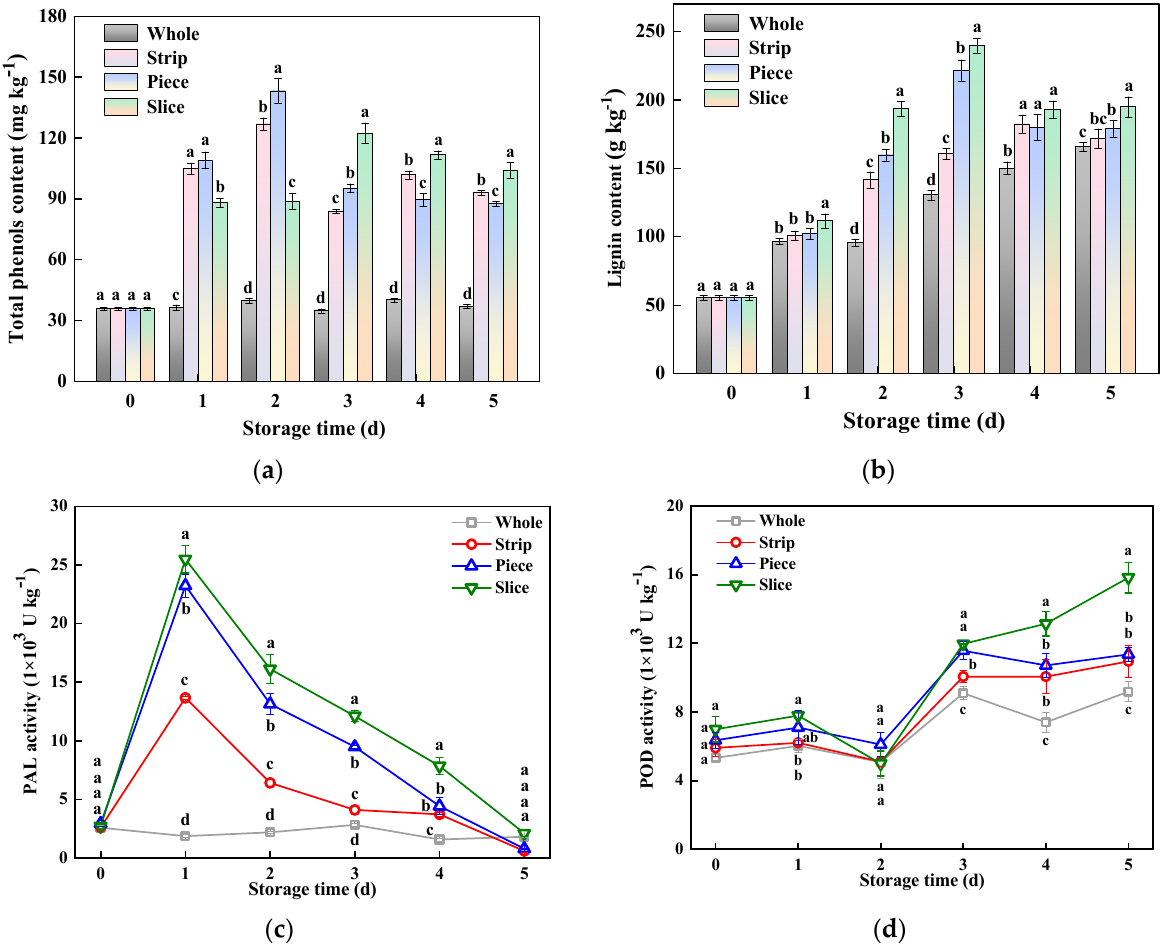
Figure 5. Effect of cutting methods on ascorbate peroxidase (APX) ( a ) glutathione reductase (GR) ( b ) phenylalanine ammonia − lyase (PAL) ( c ) and peroxidase (POD) ( d ) activity in fresh − cut cucumbers. Vertical bars represent the standard deviation of the mean (n = 3). Different letters indicate significant differences between the groups ( p < 0.05).